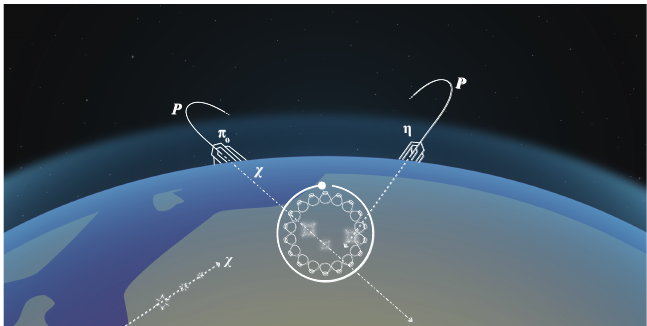
Figure 1 . Artistic rendition of this work. Millicharged particles, χ , are produced in cosmic-ray showers from neutral meson decay. They lose energy as they travel through the Earth, with only the highest energy ones reaching the detector preferentially from directions of small